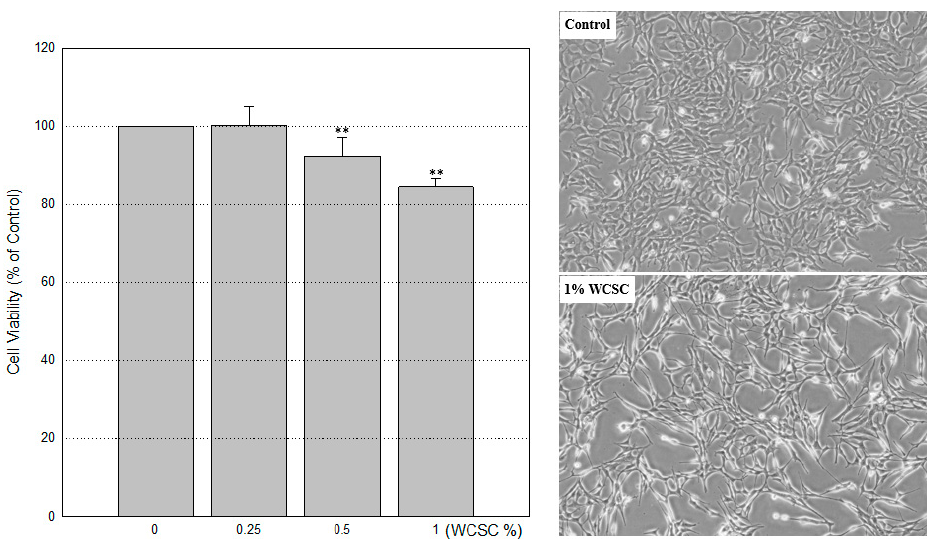
Figure 1. Decreased cell proliferation. Cell proliferation was assessed using the MTT assay, and the effects of WCSC treatment were calculated based on the absorbance of the control (100%). Experiments were independently performed three times using four wells per concentration. Data are the mean ± standard deviation (SD). ** p < 0.01. Pictures on the right show the decreased cell proliferation. Magnification: × 100.